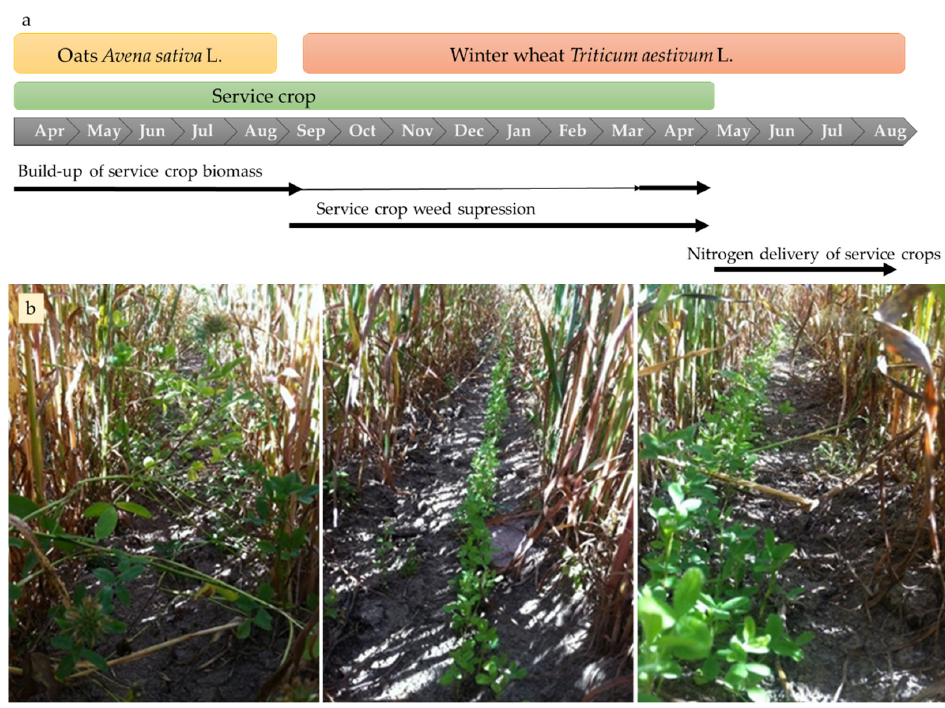
Figure 2. Visualization of the study system. ( a ) Timeline of crops grown in the field and main expected service delivery. In oats, the service crop mainly builds up biomass for later service provision. ( b ) Visualization of the placement of service crops depending on system strategy. From the left: Early Intra (service crop sown in crop row), Late Inter (service crop sown in inter-row centres at first row hoeing), and Late Adjacent (service crops sown adjacent to crop row at first row hoeing). All pictures are of the frost-sensitive annual service crop mixtures, Trifolium resupinatum and T. squarrosum . Photos by E. Lagerquist, experiment OG1, July 2017.